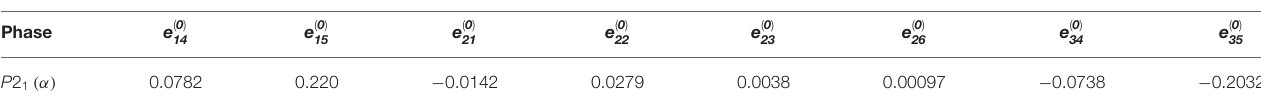
TABLE 5 | The piezoelectric tensor components e (0) ij of α -DIPAB in units of C/m 2